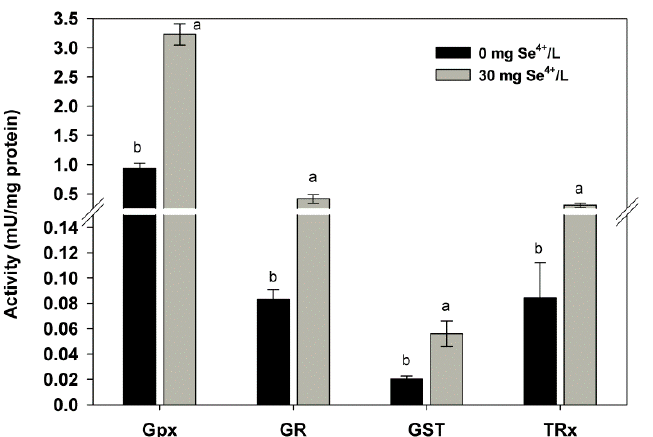
Figure 2. Effect of selenium on the activity of antioxidant enzymes in yeast biomass C. utilis (glutathione peroxidase, GPx; glutathione reductase, GR; glutathione S-transferase, GST; thioredoxin reductase, TRxR). Means with the same letter (a,b) did not differ significantly (acc. Tukey’s HSD test).